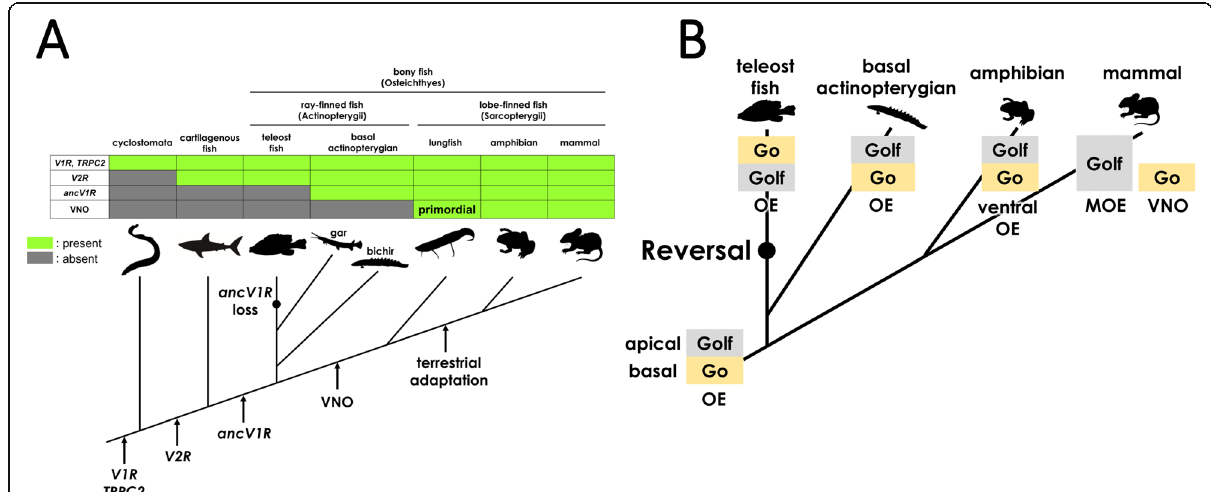
Fig. 7 The origin and evolution of the VNO in vertebrates. ( A ) Possible scenarios for the timing of VNO acquisition and a step-by-step evolution of the vomeronasal system in vertebrates. Considering that the VNO-like region was not found in bichir and gar, the acquisition of the VNO is likely to be later than the common ancestor of Sarcopterygii. However, the gene sets for advanced vomeronasal sensory neurons had already existed in the common ancestor of Osteichthyes. ( B ) Reversal in the pattern of Go / Golf expressions. Considering that the pattern of expression of Go (basal) and Golf (apical) in the olfactory epithelium of bichir is similar to that of amphibians (and partly similar to the VNO of mammals), it is parsimonious that the reversal of Go / Golf expression occurred in the common ancestor of teleost